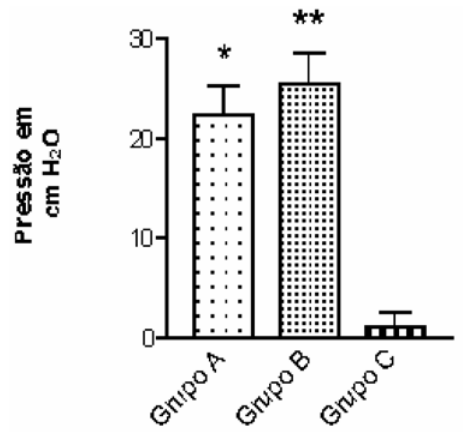
FIGURA 4 - Pressão do refluxo colo-ileal (cm H O) em animais 2 com válvula ileocecal fisiológica (Grupo A), neoválvula (Grupo B) e anastomose íleo-cólica término-terminal (Grupo C). Cada barra representa a média ± erro padrão médio de pelo menos 7 animais. * e ** indicam, respectivamente, p<0,05 e p<0,001, em relação ao Grupo